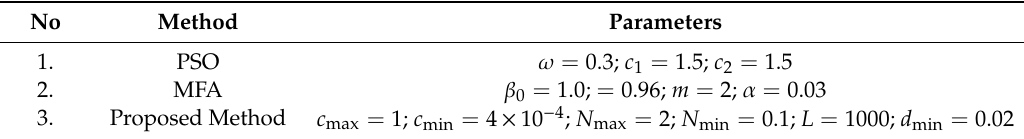
Table 3. Algorithm parameters.